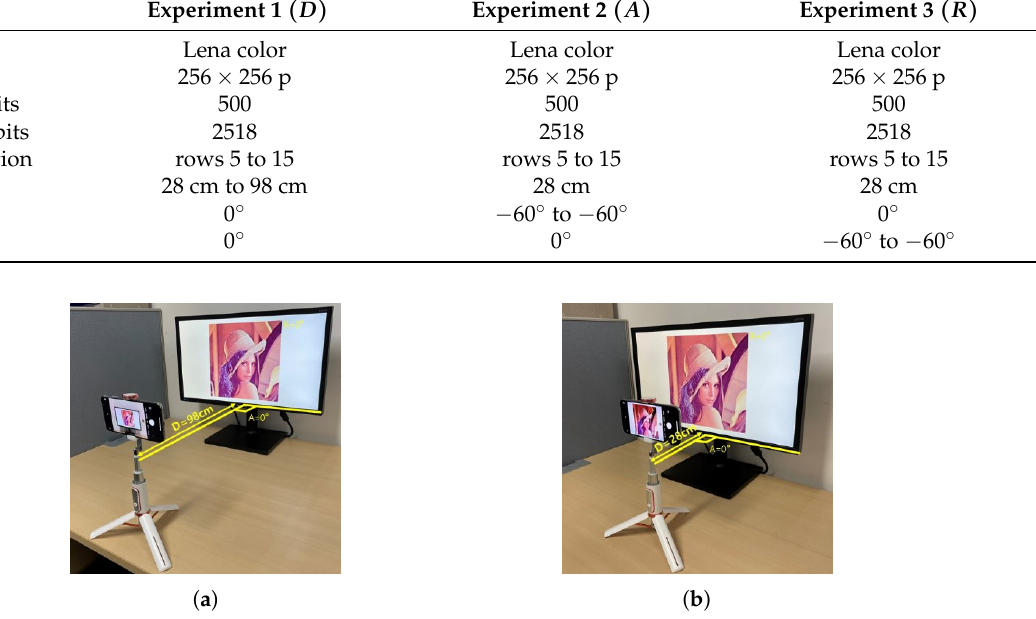
Figure 14. Experimental setup according to display-camera distance. ( a ) D = 98cm. ( b ) D =